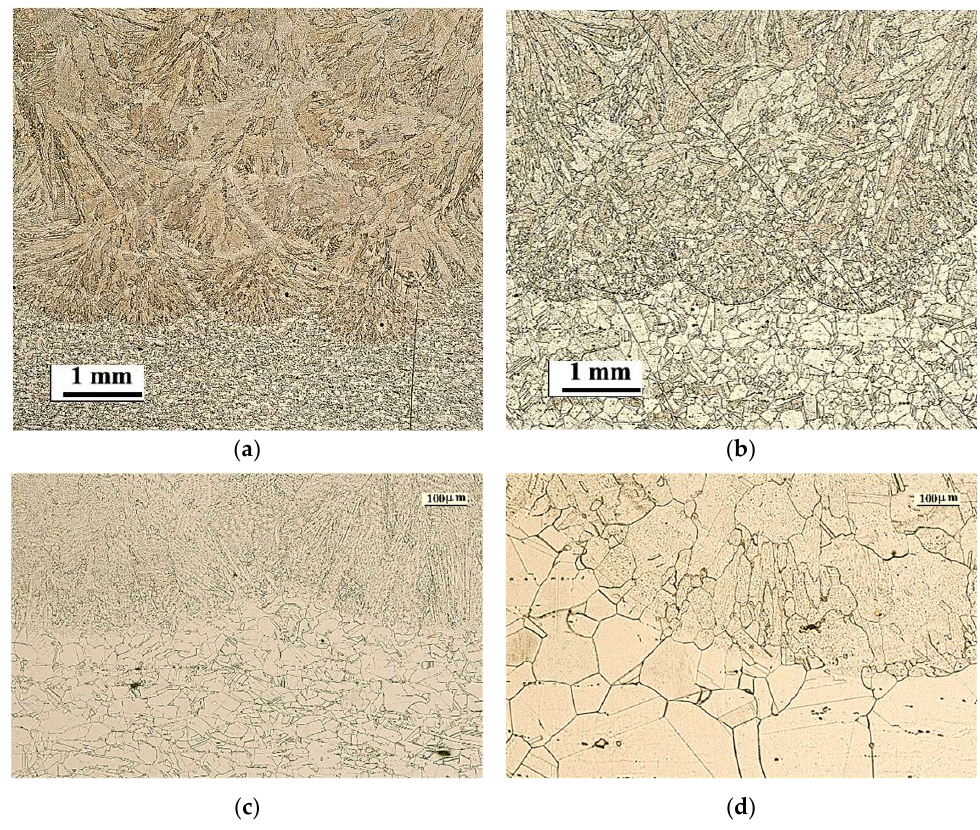
Figure 7. Cross-sections structure on the dilution zone: ( a , c ) as-deposited; ( b , d ) solubilization and aging (STA).